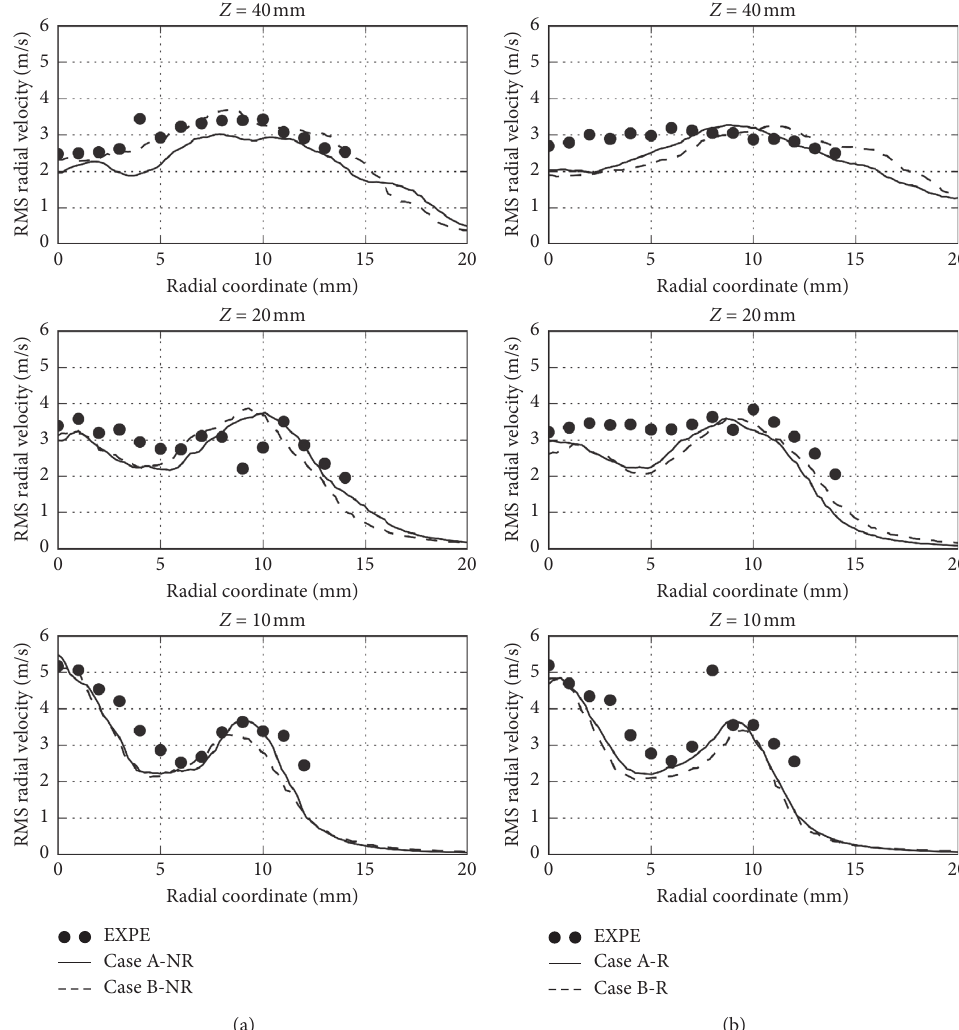
Figure 13: Radial profiles of radial velocity RMS for nonreacting (a) and reacting case (b). Symbols: experiments, solid line: case A dashed line: case